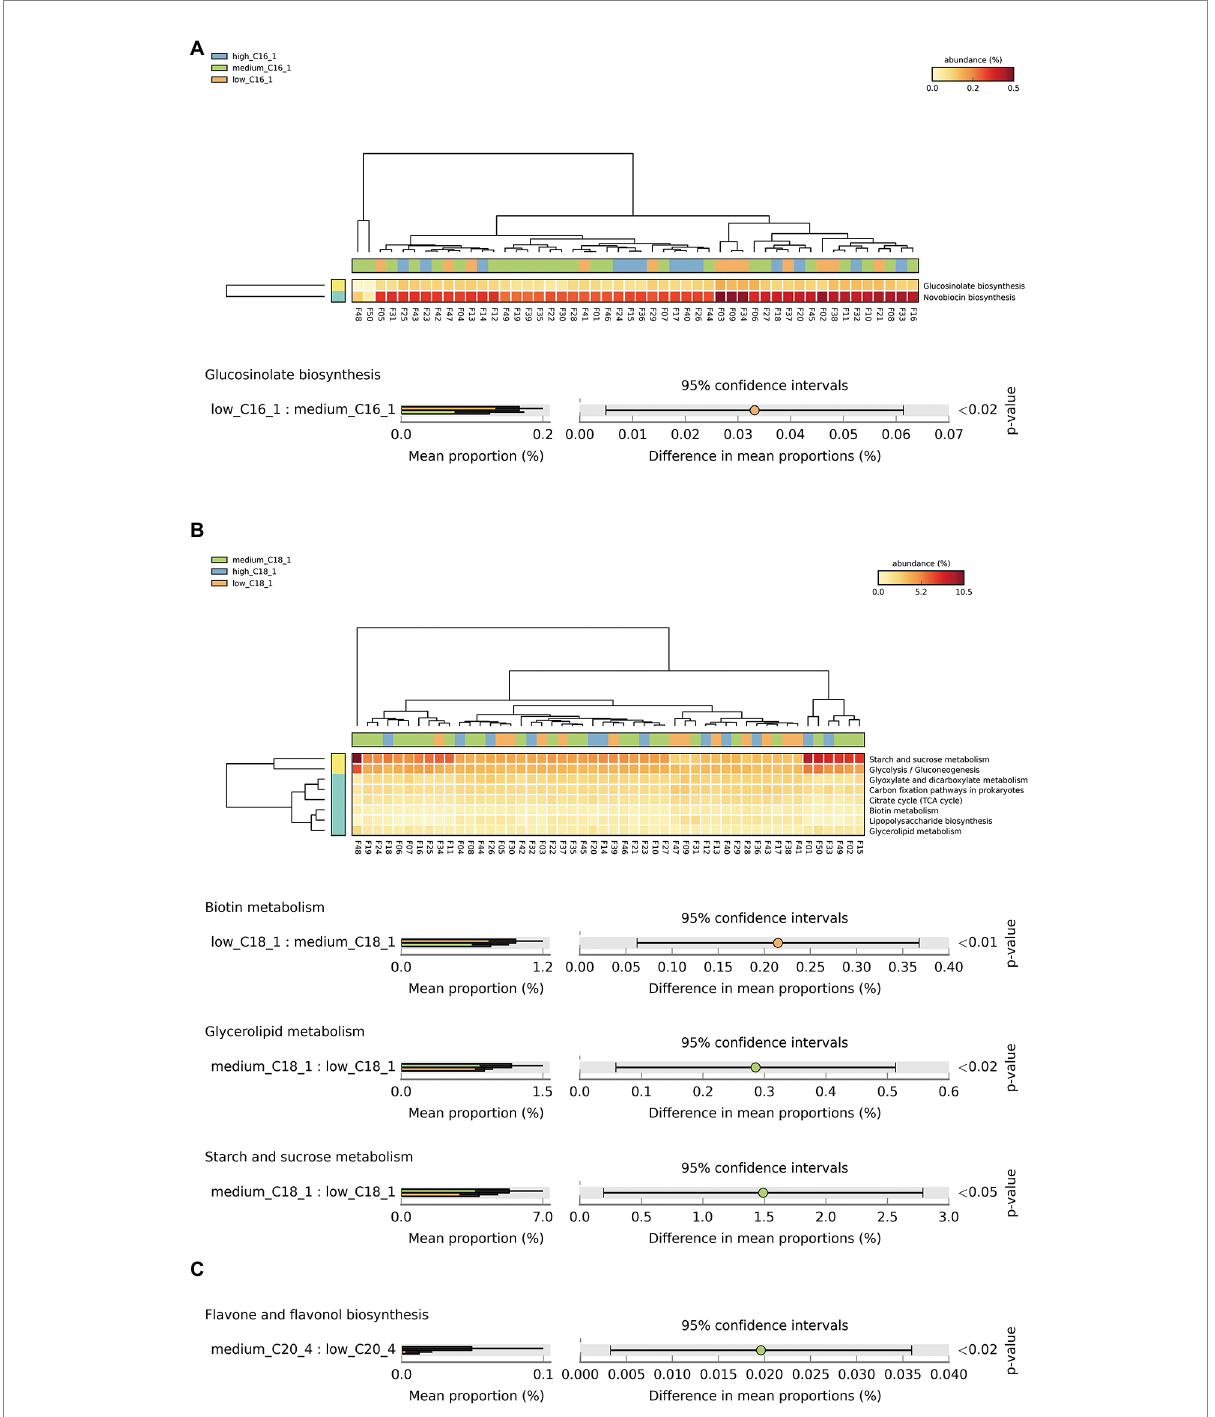
FIGURE 3 Analysis of specific long-chain FAs and KEGG tertiary metabolic pathway abundance levels in human milk with different FA contents. ( A–C) The KEGG tertiary enrichment and differential pathways of breast milk C16:1, C18:1, and C20:4, respectively, in different content groups (orange, green, and blue indicate low, medium, and high content, respectively). Kruskal–Wallis rank sum test was used to compare the KEGG functional levels of different FA groups in breast milk (orange, green and blue indicate low, medium, and high content, respectively). The color transition from yellow to red indicates that the abundance of this metabolic pathway gradually increases in the